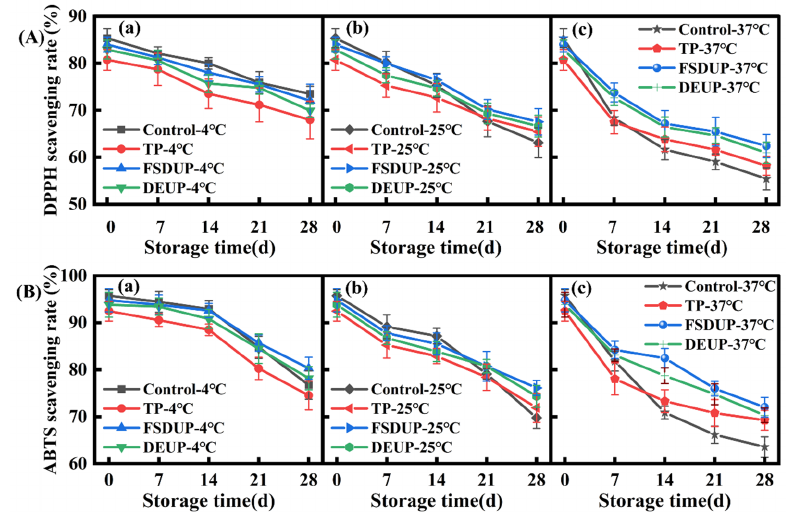
Figure 6. Changes in DPPH ( A ) and ABTS ( B ) free radical scavenging capacity of strawberry clear juice during storage after thermal pretreatment and multi-mode thermosonication. TP: thermal pre- treatment; FSDUP: flat sweep-frequency dispersive ultrasound pretreatment; DEUP: dual-fre- quency energy-gathered ultrasound pretreatment.